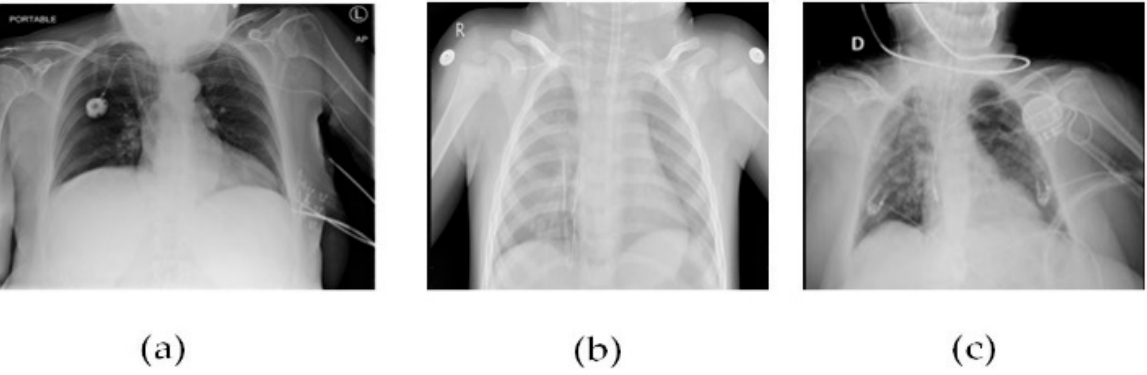
Figure 5. ( a ) Patient healthy image, ( b ) Patient with pneumonia, and ( c ) Patient with +Ve COVID-19 images COVID-19 negative.